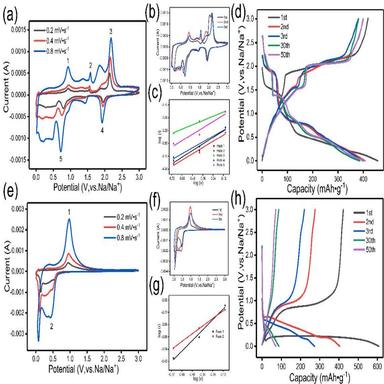
(a) CV curves of the CuS electrode at different scan rates; (b) CV curves of the initial three cycles of the CuS electrode; (c) Log(i) versus log(v) plots at specific peak currents of CuS electrode; (d) Voltage-capacity curve of CuS electrode; (e) CV curve of ZnS electrode at different scan rates; (f) CV curve of the initial three cycles of the ZnS electrode; (g) Log(i) versus log(v) plots at specific peak currents of ZnS electrode; (h) Voltage-capacity curve of ZnS electrode.